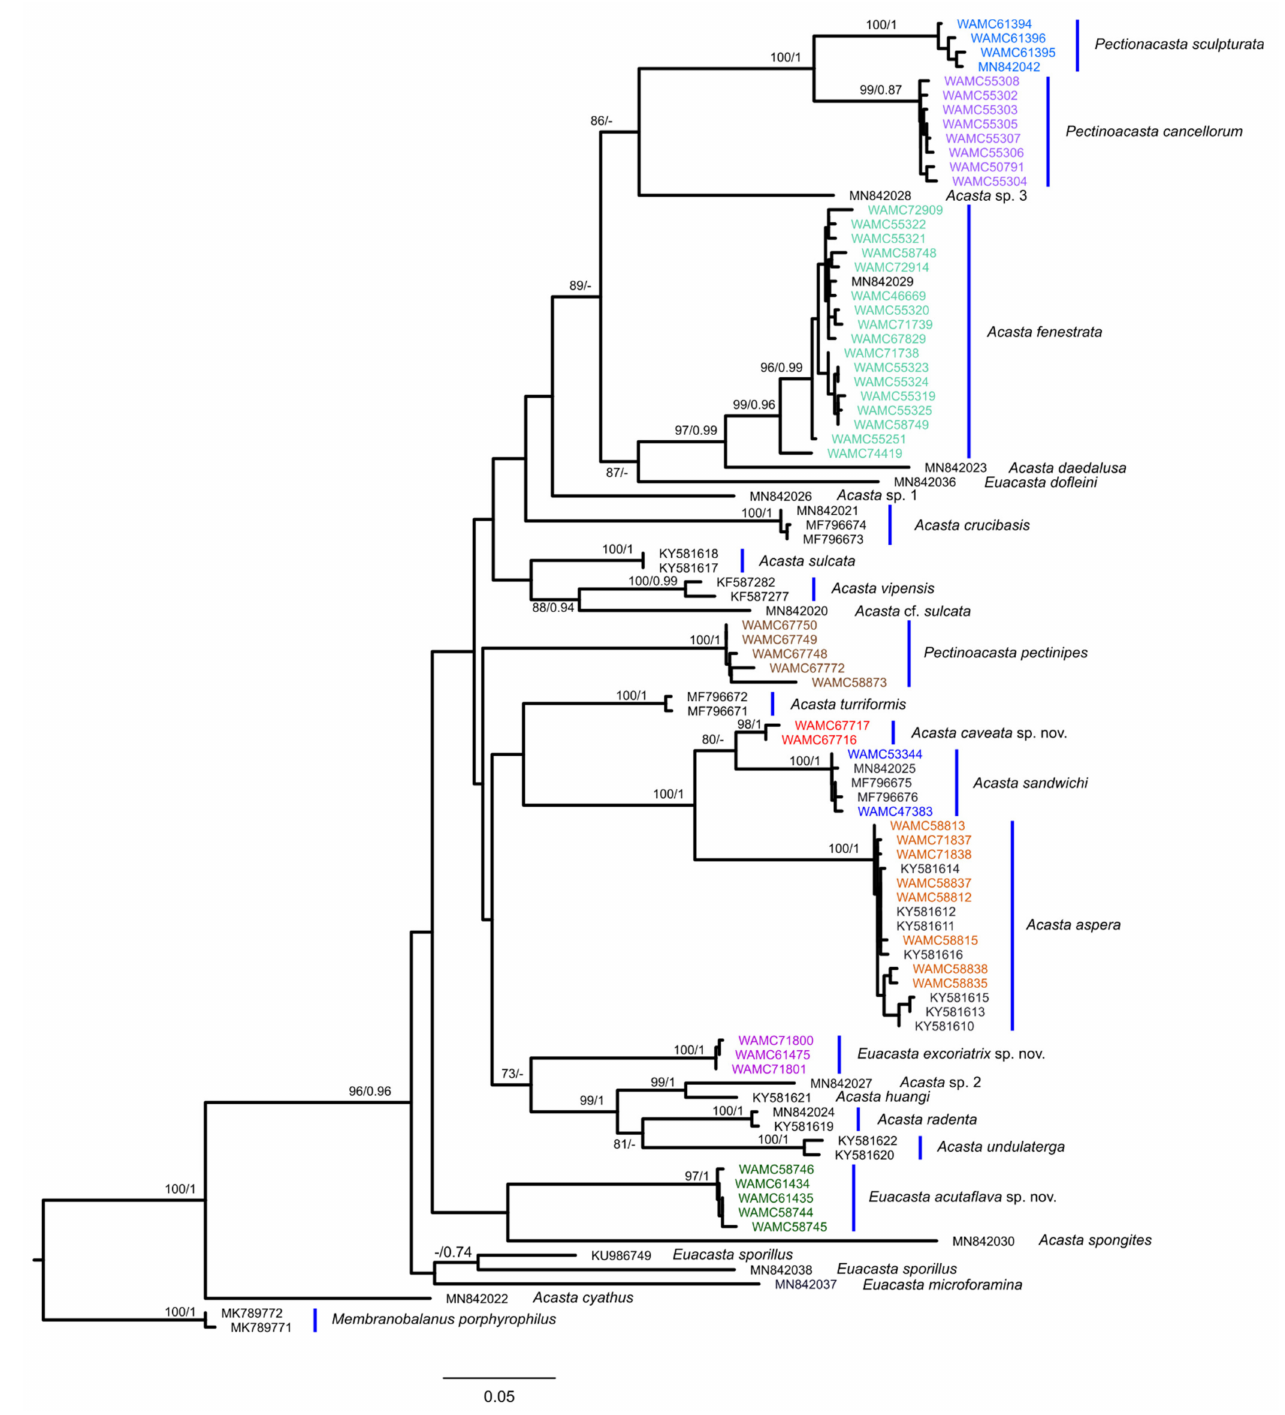
Figure 29. Maximum likelihood (ML) tree based on COI dataset. Tips are labelled with institutional accession numbers for newly published sequences (coloured by species) or GenBank accession numbers for previously published data (black). Node labels are supporting bootstrap (bs) and posterior probability (pp) values, respectively, with only values ≥ 70% bs or 0.7 pp shown (- indicates where only one method did not meet these thresholds). Scale bar indicates number of expected substitutions per